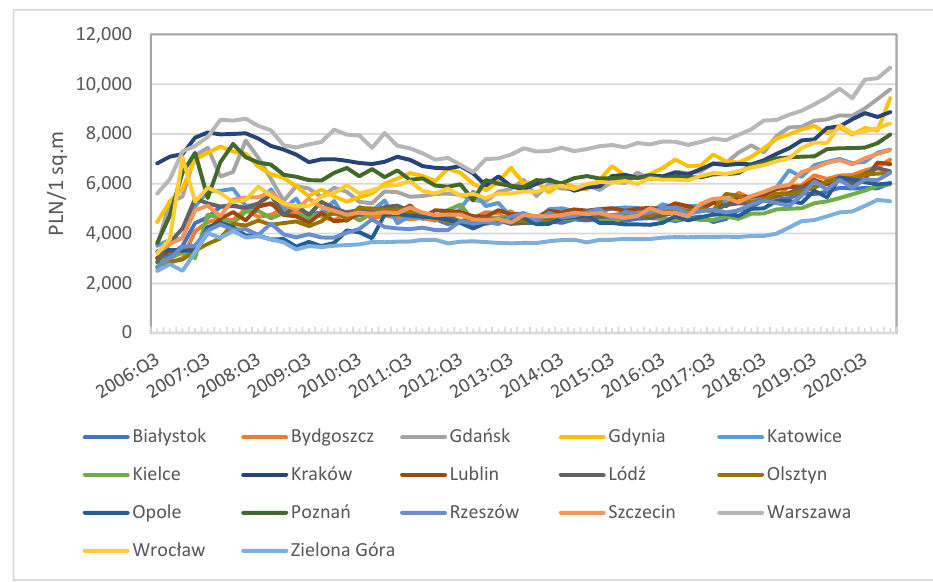
Figure 1. Transaction prices on secondary market—17 Polish cities.